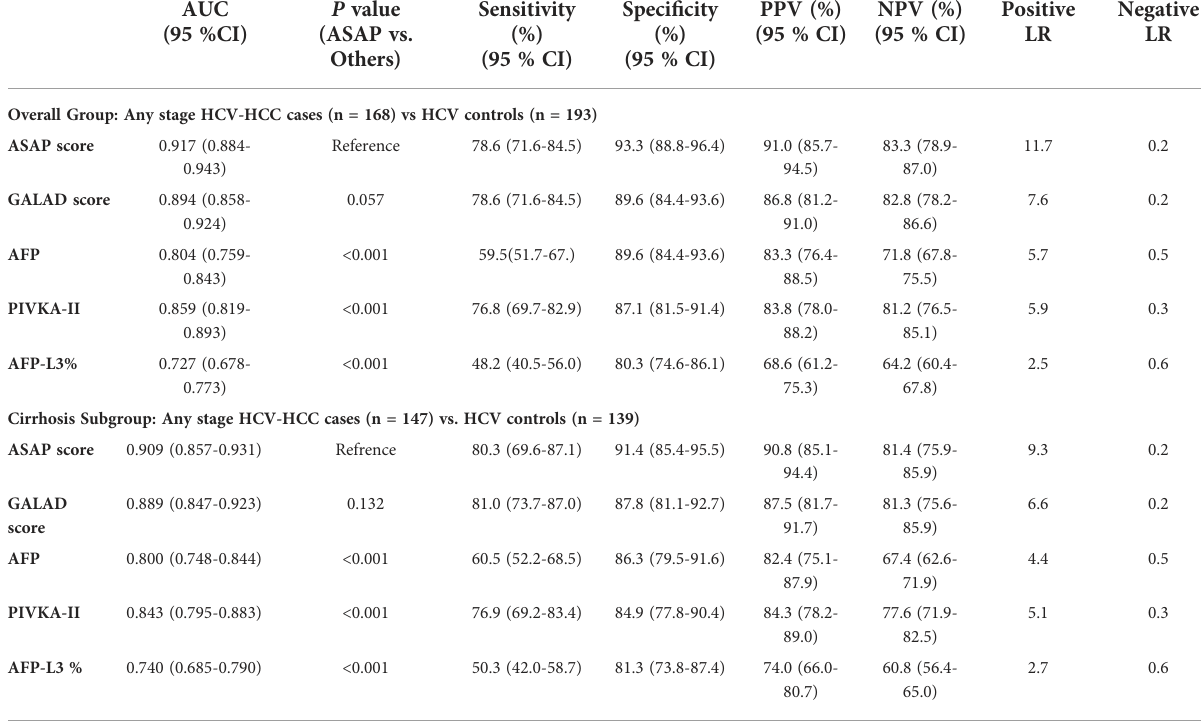
TABLE 2 Diagnostic performances of the ASAP score, the GALAD score, AFP, PIVKA-II, and AFP-L3% for detecting any stage HCV-HCC in the overall group and the cirrhosis subgroup. P value AUC (95 %CI) (ASAP vs.